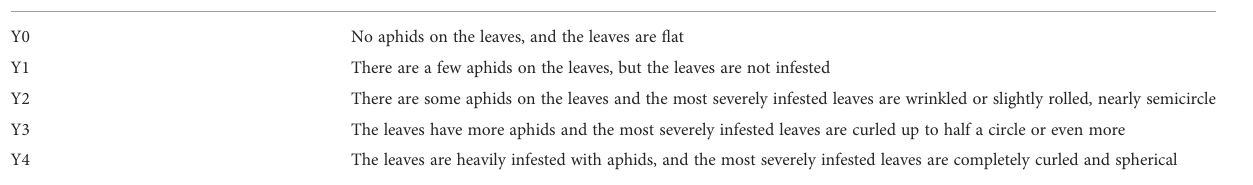
TABLE 1 Severity grading standards for cotton aphids.